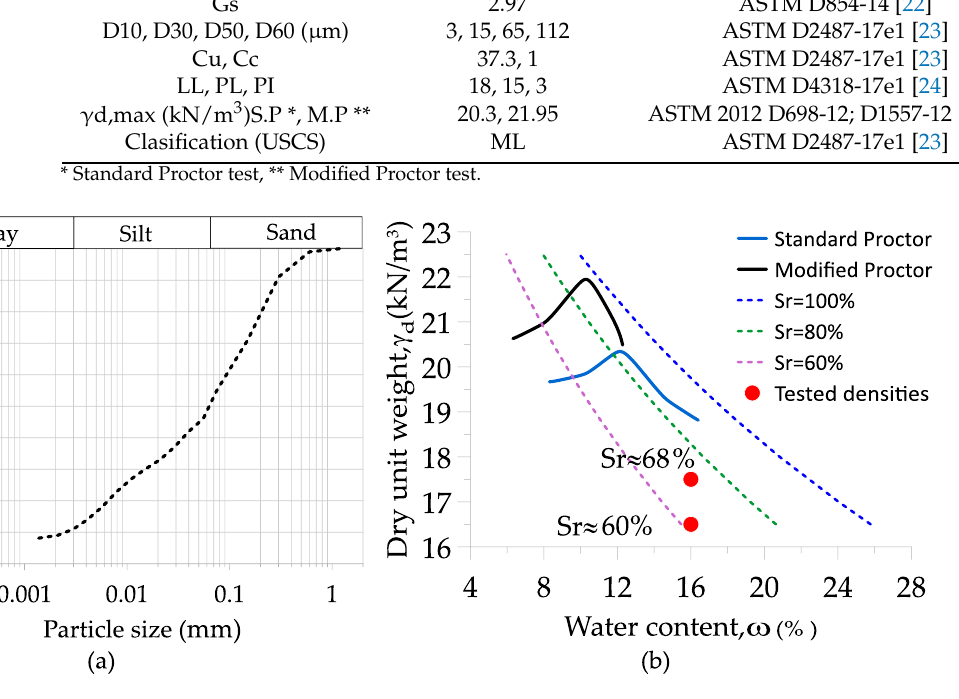
Figure 2. ( a ) Particle size distribution of the material tested. ( b ) Water content and initial mounting dry unit weight.